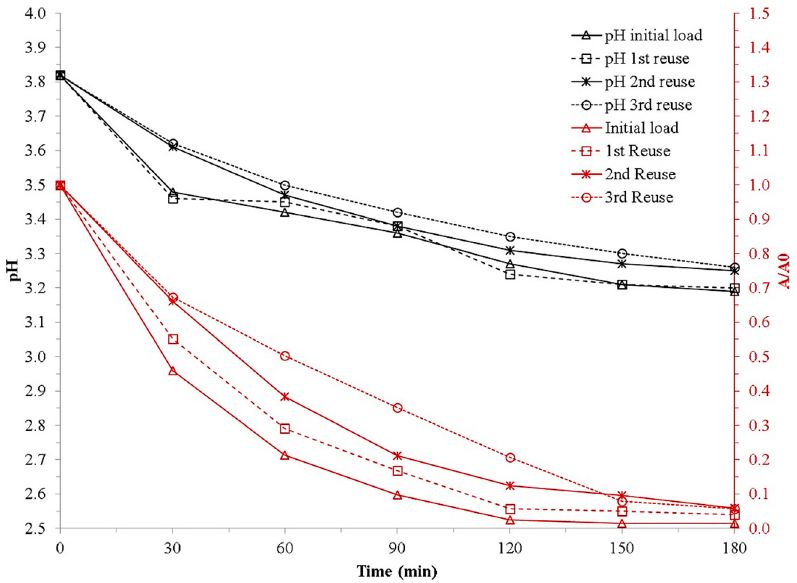
Figure 9. Ilmenite stability after 4 tests (3 reuses) ([H 2 O 2 ] = 10 mM, pH 0 = 3.8, UVC light).